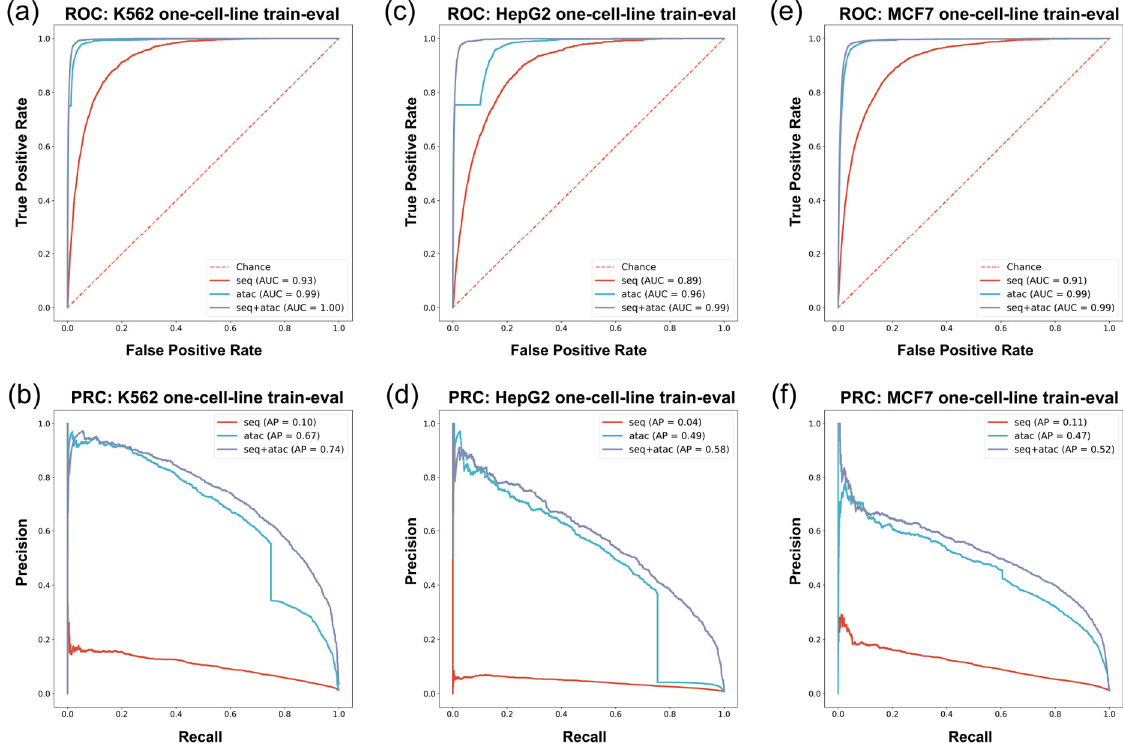
Figure 3. ROC/PRC of in vivo G4 prediction with training set and test set derived from same cell line. The vertical axis and horizontal axis are True Positive Rate = TP/(TP+FN) and False Positive Rate = FP/(FP + TN) for ROC, precision, and recall for PRC. Since in vivo G4 prediction is an imbalanced data problem where the number of positive samples is overwhelmingly more than that of negative samples, the Area Under PRC (AP) can reflect the performance of models more effectively. ( a , b ) The ROC/PRC of K562 cell line. ( c , d ) The ROC/PRC of HepG2 cell line. ( e , f ) The ROC/PRC of MCF7 cell line. Table 3. K562 cell line training – evaluation results.